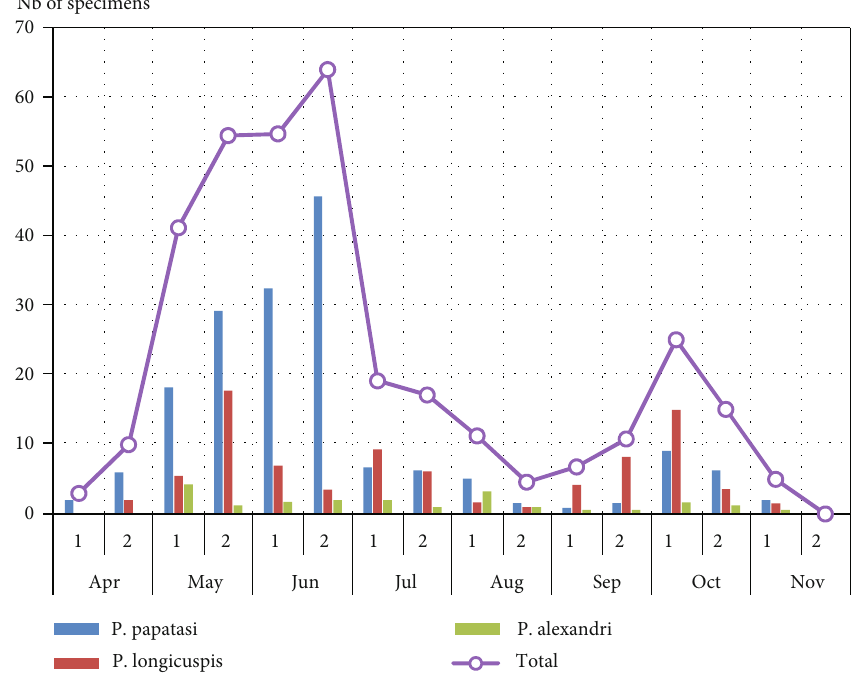
Figure 2: Bimonthly capture records for sand fl ies in Mougni locality.